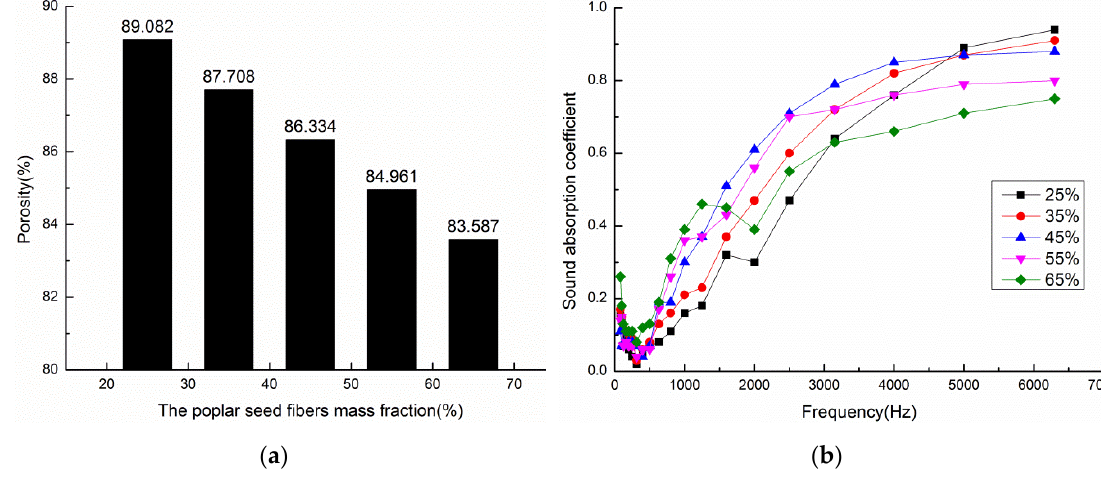
Figure 2. Porosities and sound absorption coefficient curves of composite materials with different mass fractions: ( a ) Porosities of composite materials ( b ) Sound absorption coefficient curves of composite materials.